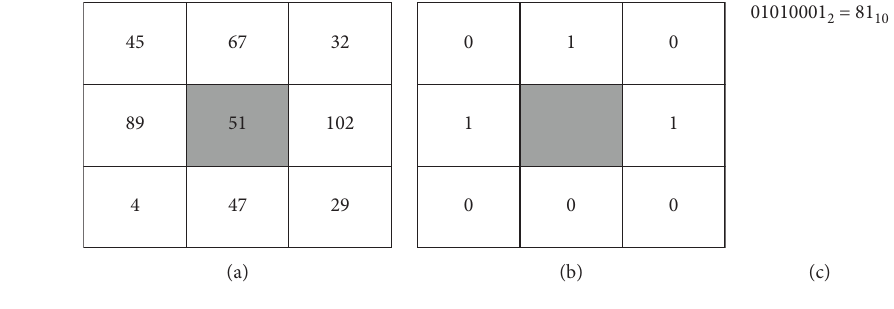
Figure 10: LBP operation given P � 1 and R � 1 [82].